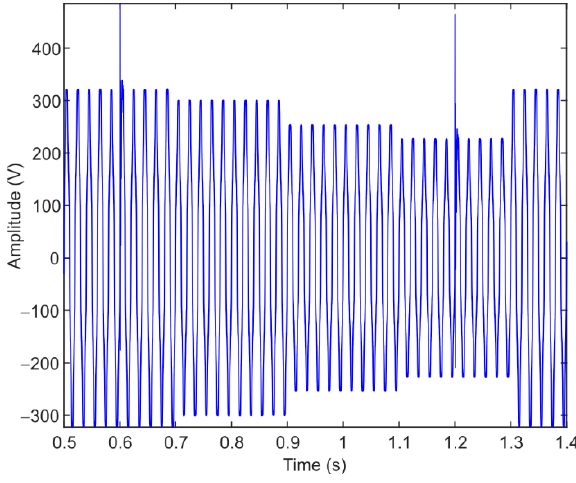
Figure 11. Model of multicomponent